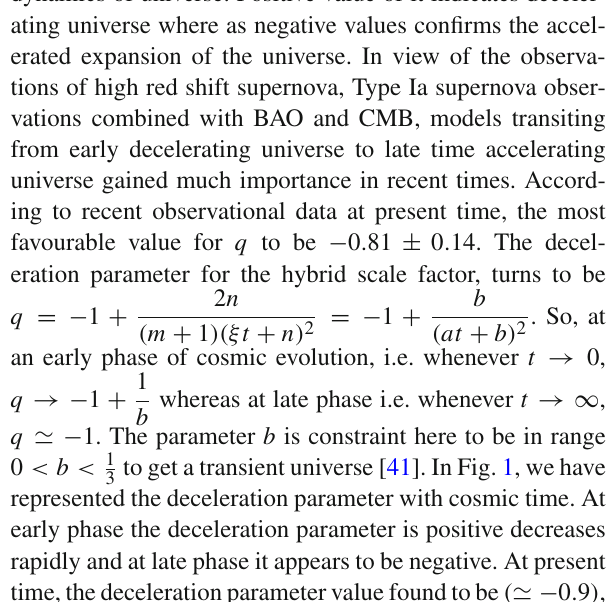
smaller effect on ρ DE than string fluid. However, this small effect due to mix fluid matter cannot be ruled out. Figure 3 represents variation of EoS parameter (ω DE ) w.r.t appropriate choices of bulk viscous coefficients ((cid:12) = , − 2 , − 1 ) . When compared to the de Sitter model and 0 , − 1 3 3 powerlawmodel[42],wefoundnatureofEoSparametersare directly proportional to the increasing value of viscous coeffi- cients ((cid:12)) till late phase. But the behaviours of the